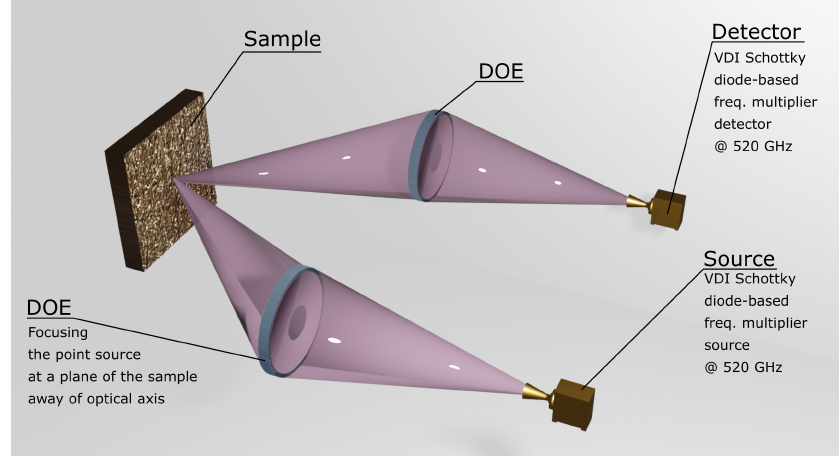
Figure 1. The configuration of the in-reflection setup for the sample examination using two off-axis diffractive structures (DOEs). The radiation from the divergent source illuminates the diffractive element focusing it at some angle and at some distance after the structure. Such solution can help in minimizing the distance between the element and the sample, thus the off-axis focusing is required. Then, the radiation reflected or scattered on the sample is collected by the element with the same shape and geometry to focus this radiation on the detector. The concept is general, allowing for the arbitrary choice of the source and detector of radiation as well as sample under test. Here, VDI Schottky diodes with frequency multipliers have been